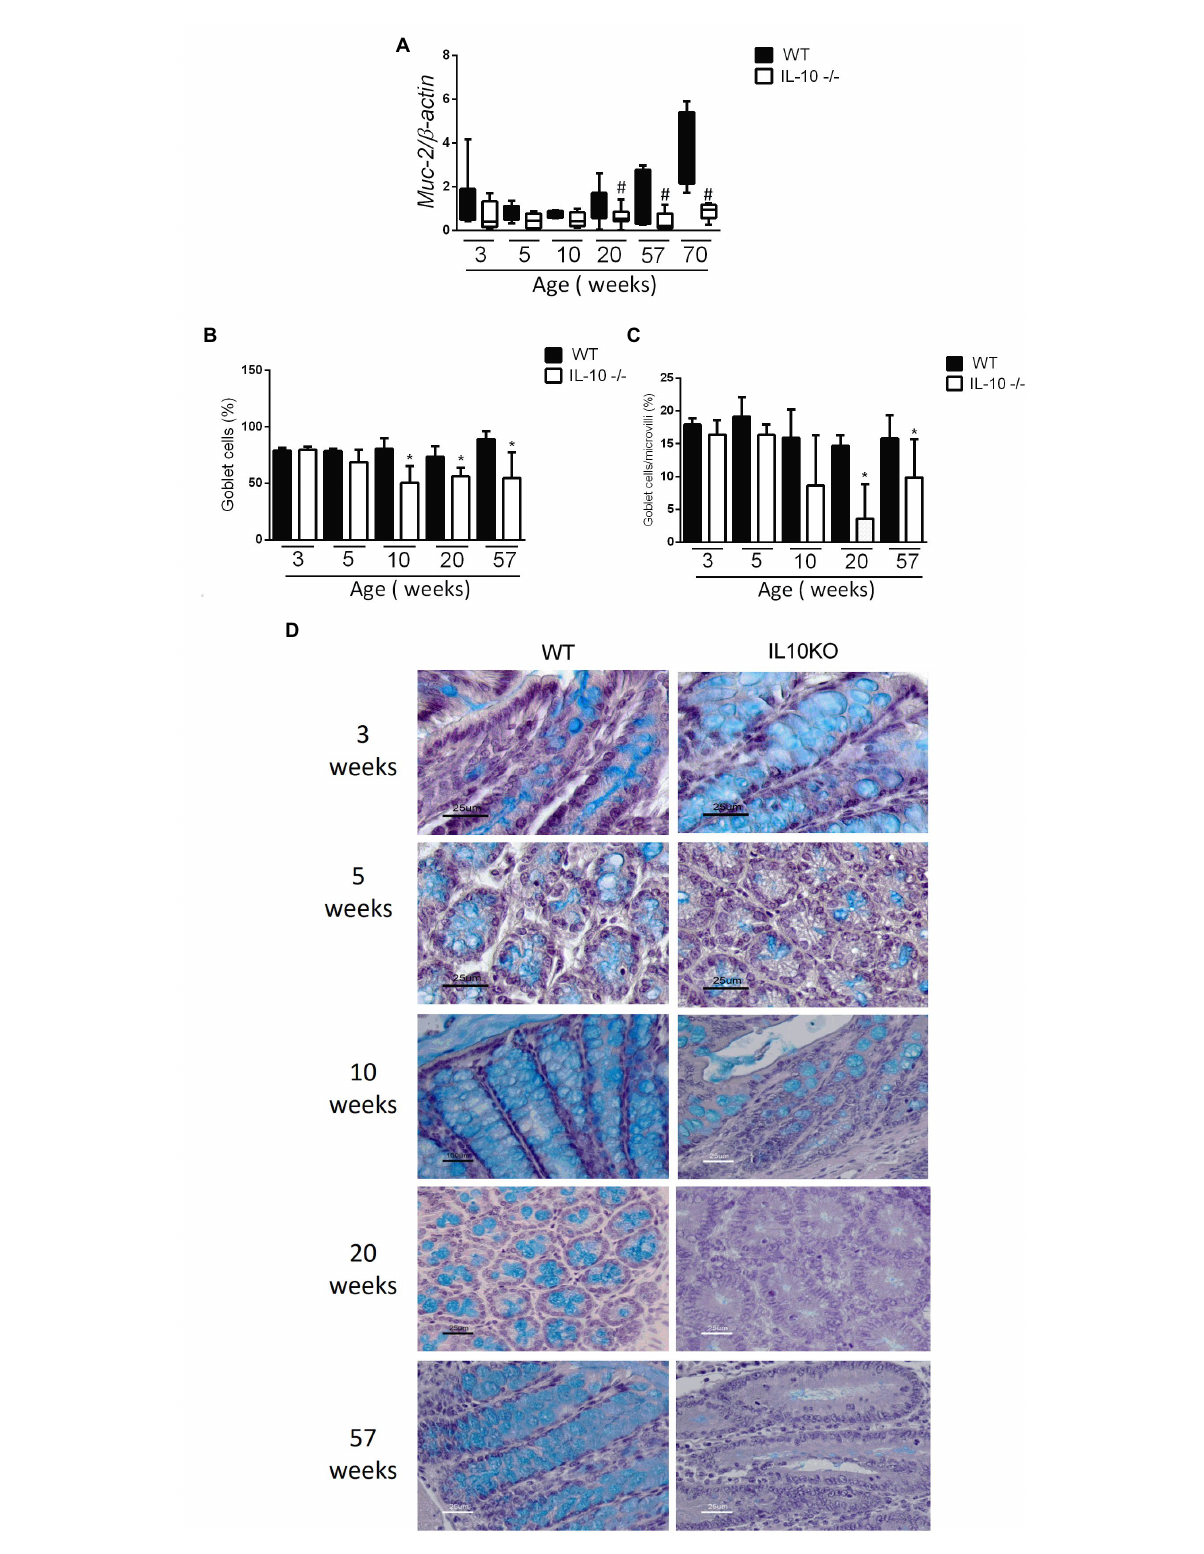
FIGURE 4 (A) Comparison of gene expression of MUC-2 gene in colon of WT and IL-10 − / − mice in all evaluated ages. # p < 0.05 to respect to WT of the same age. The count of total goblet cells (B) and goblet cells per microvillus (C) was performed blindly by two independent researchers from images obtained with ACT-1 software. C57Bl/6 wild type (WT) group was represented in black and IL-10 deficient mice (IL-10 − / − ) group in white. # p < 0.05 to respect to WT of the same age. (D) Histological sections of the colon stained with alcian blue and hematoxylin in WT and IL-10 − / − at 3, 5, 10, 20, and 57 weeks of